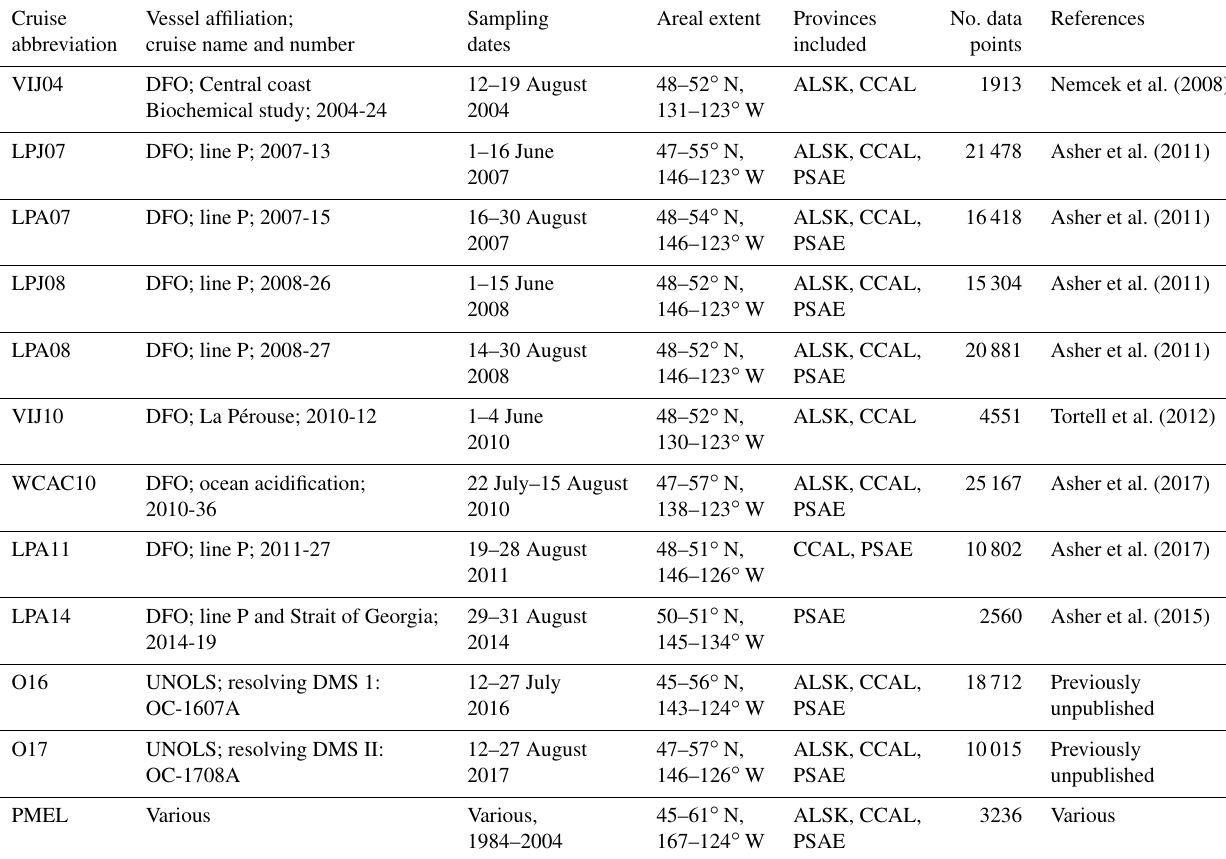
Table 1. Summary of DMS data included in this study. With the exception of the PMEL data, all measurements are derived from membrane inlet mass spectrometry